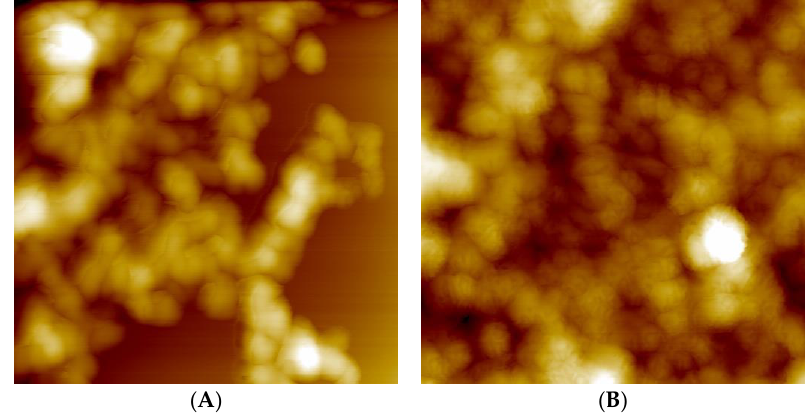
Figure 8. ( A ) 2 × 2 µm scanning force microscopy (SFM) image of PLL/CS-1.0 (PEC 0.9)